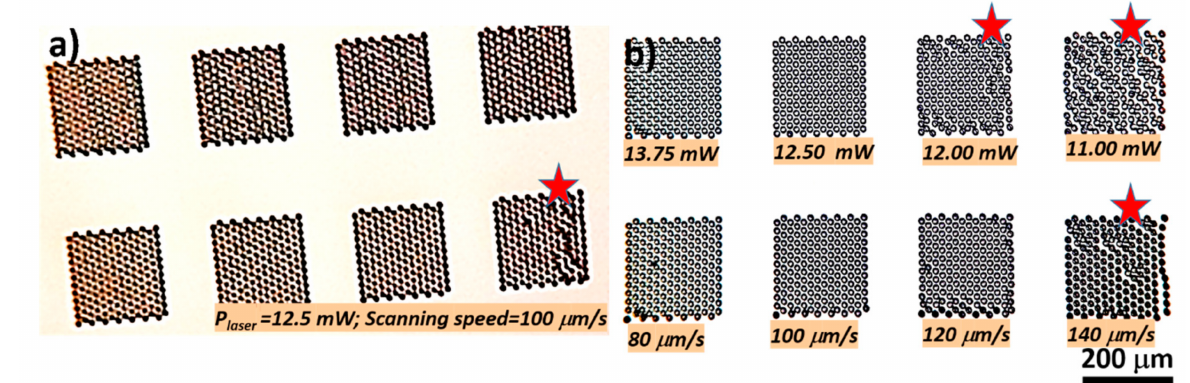
Figure 1. Optical images of arrays of nanostructured mushroom-like pillars (NMPs) arranged in hexagonal lattices, fabricated by LDW via TPP of IP-Dip photopolymer: ( a ) using the same geometry and writing parameters; ( b ) using different laser powers (upper panel) and scanning speeds (lower panel). Writing parameters (laser power, scanning speed) are indicated on each image. On both ( a , b ) the red stars mark the structures that lost their stability on the glass